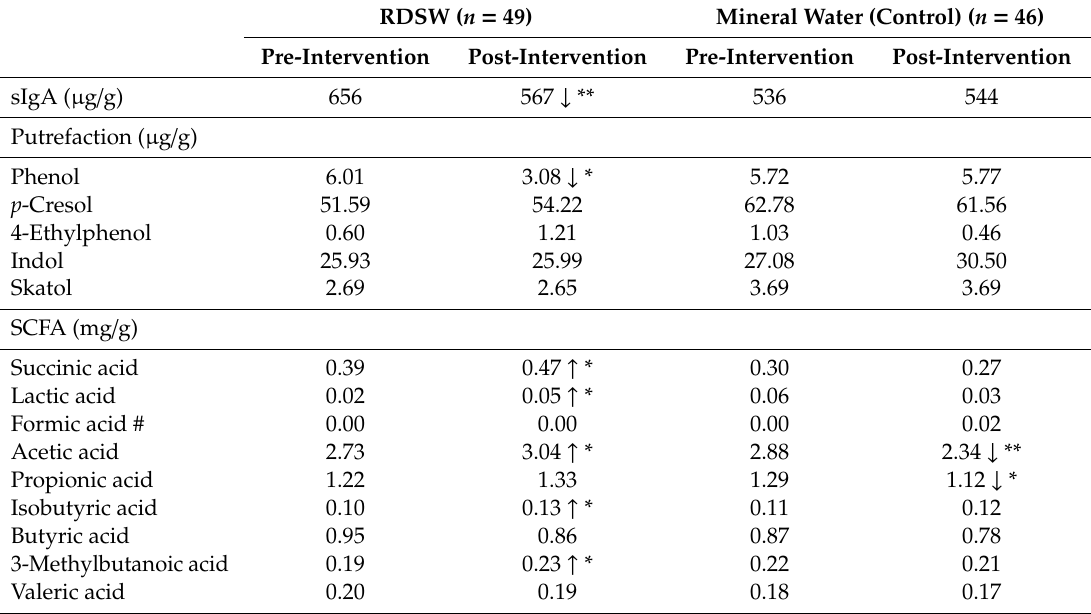
Table 2. The values of fecal biomarkers of two groups through the intervention (average). RDSW ( n = 49) Mineral Water (Control) ( n = 46) Pre-Intervention Post-Intervention Pre-Intervention